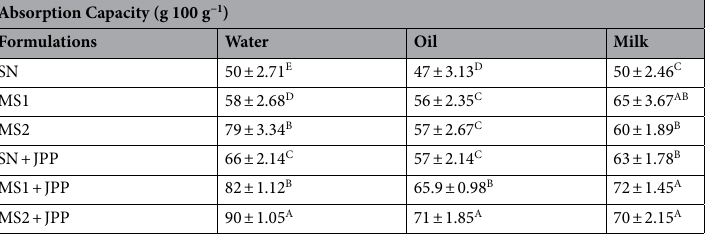
Table 4. Water, oil and, milk absorption capacity of all formulations. Different capital letters indicate a significant difference ( p < 0.05) between formulations SN native starch, MS1 Modified starch by α-amylase,